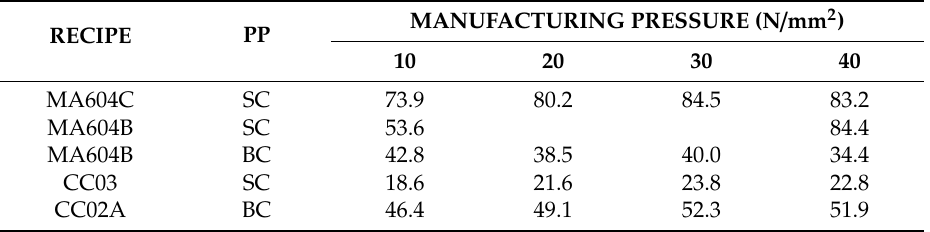
Table 13. Cold compression strength (average of four tests) of the agglomerates produced and tested at RWTH.